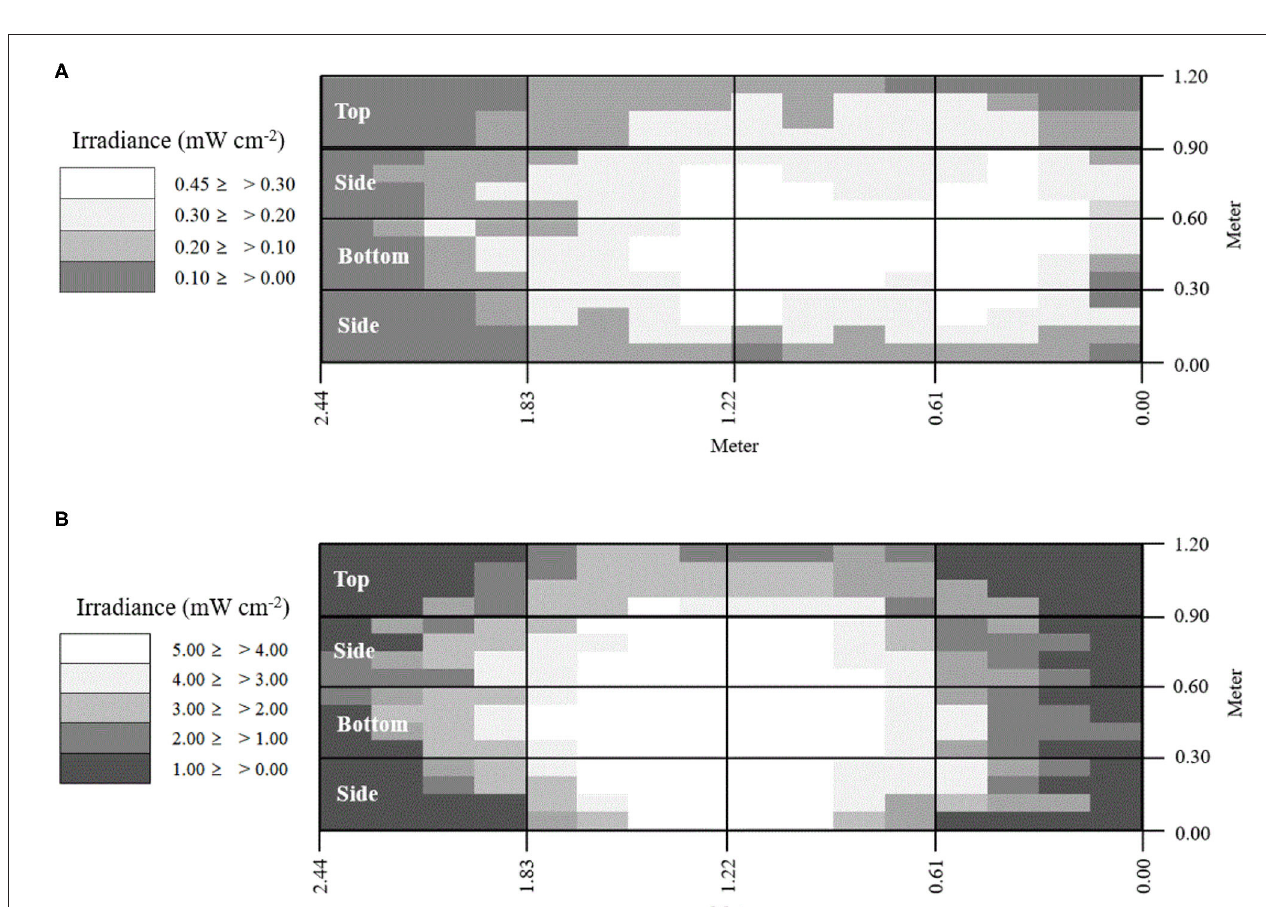
FIGURE 3 | Surface map of UV-A light effective exposure. (A) Fluorescent, (B) LED.